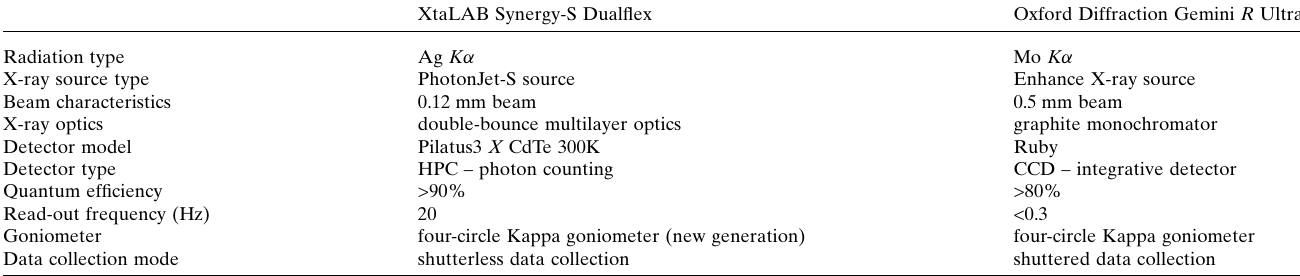
Table 1 Comparison of technical characteristics of the diffractometers.